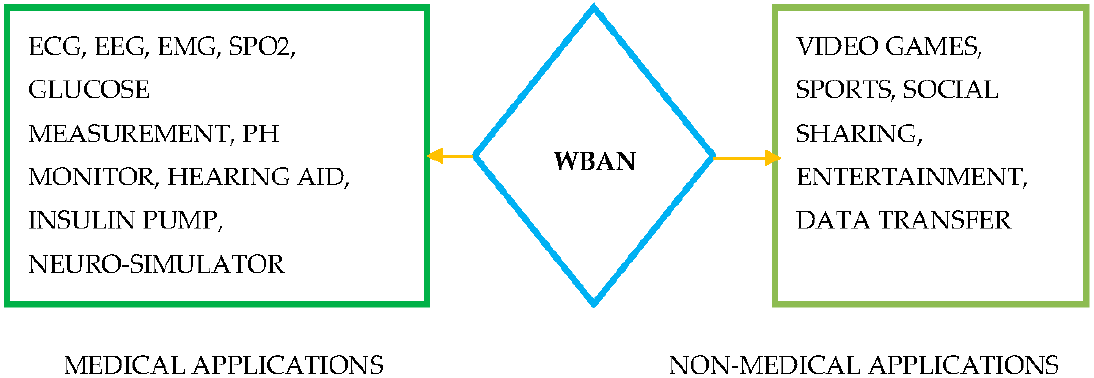
Figure 1. Wireless Body Area Network (WBAN) Applications.